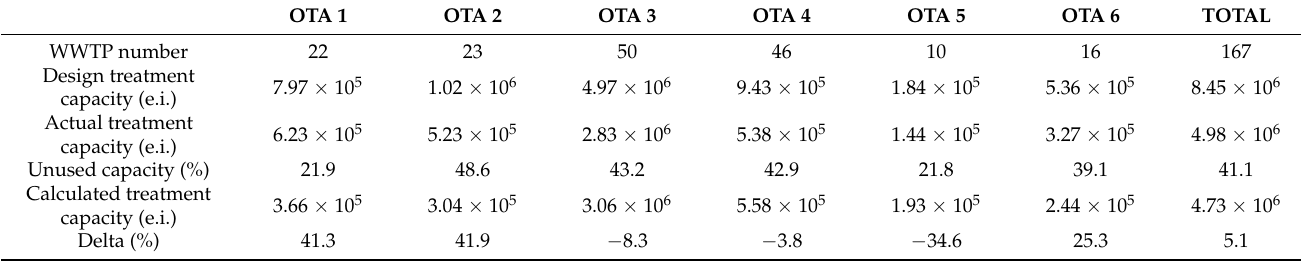
Table 1. Information concerning the wastewater treatment plants (WWTPs) located in the Piemonte region with a design capacity of more than 2000